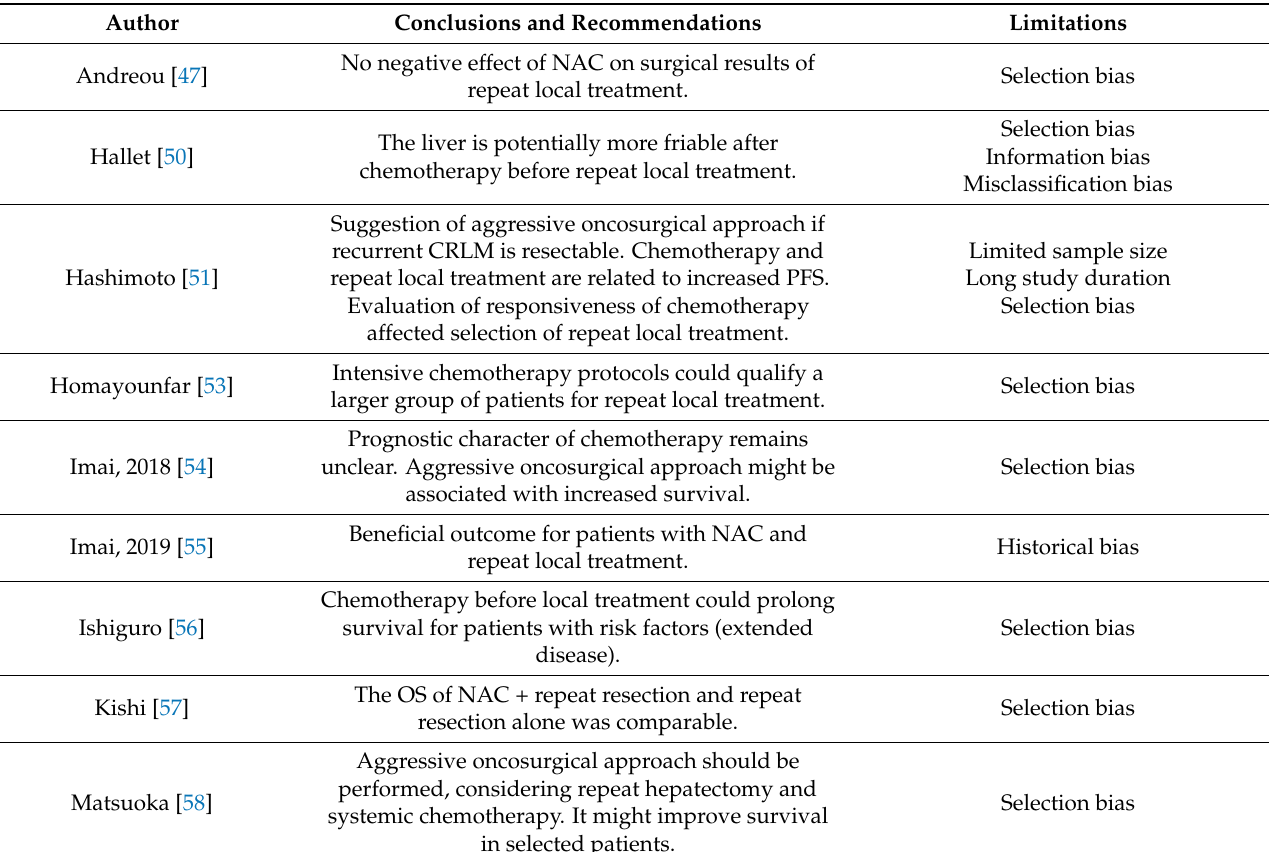
Table 4. Conclusions, recommendations, and limitations for recurrent